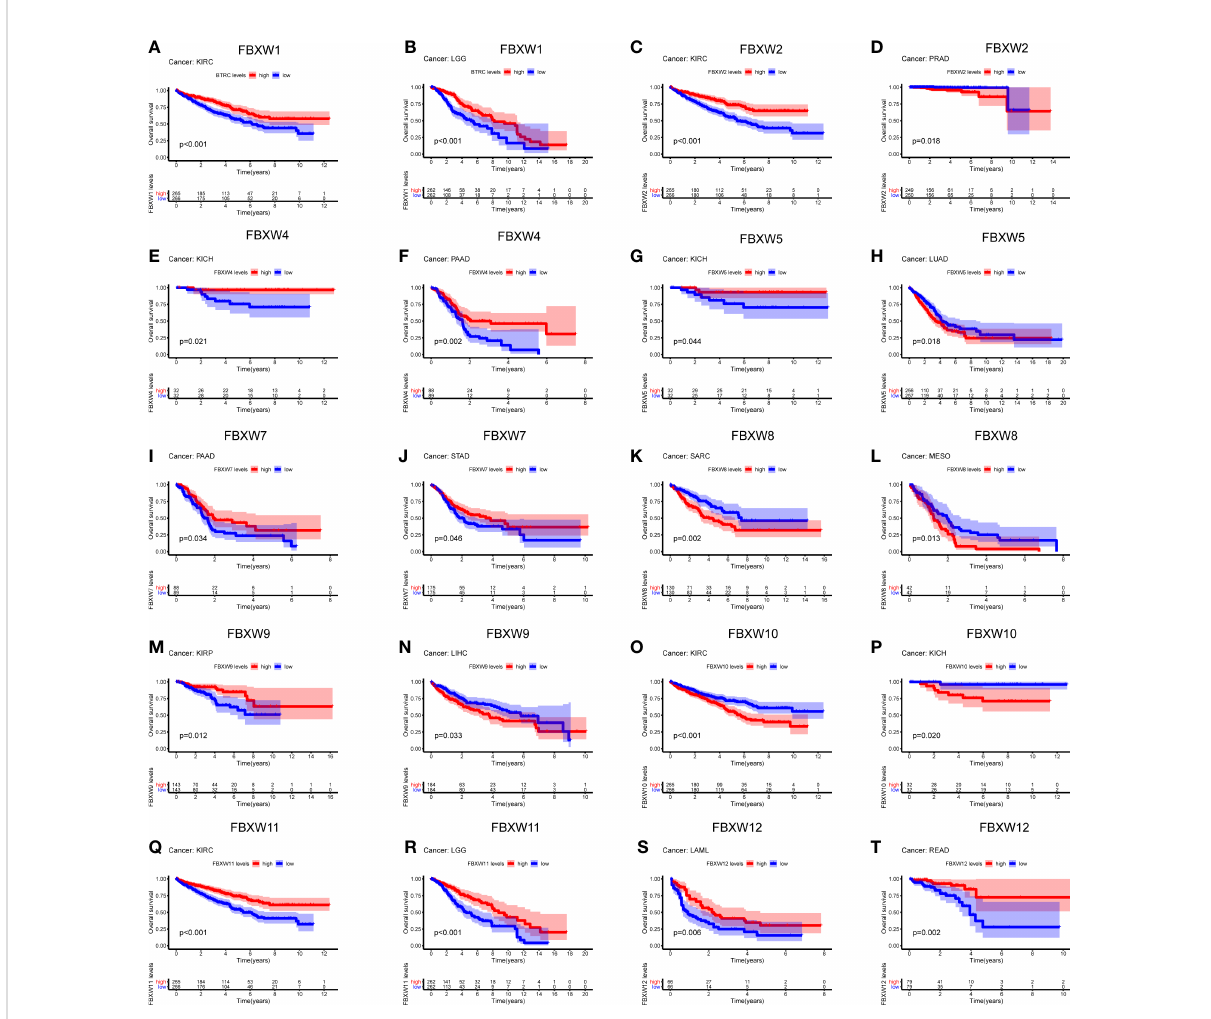
FIGURE 6 Survival analysis of FBXW family genes (A – T) across multiple cancer types. The red line in the photos indicates high expression and the blue line in the photos indicates low expression. P value less than 0.05 is considered as